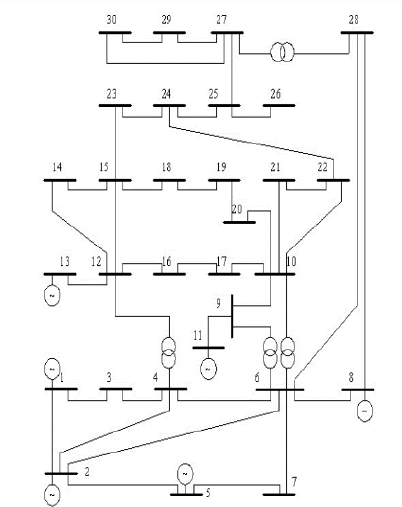
Figure 4. Analysis of LOSI